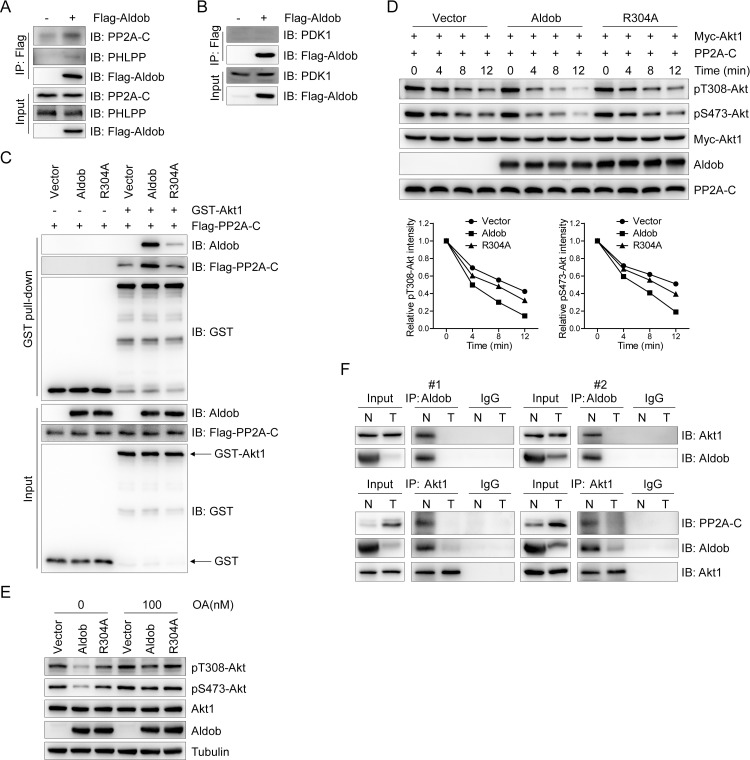
Aldob regulates Akt activity through protein phosphatase PP2A.(A and B) IB analysis of anti-Flag IP and WCL derived from Huh7 cells transfected with the indicated constructs. (C) GST pull-down assays were performed with WCL derived from Flag-PP2A-C-transfected Huh7 cells and recombinant proteins GST-Akt1 and WT-Aldob or Aldob-R304A mutant. GST was used as the negative control. (D) In vitro PP2A dephosphorylation assays were performed with phosphorylated Myc-Akt1 and active PP2A in the presence or absence of recombinant WT-Aldob or Aldob-R304A mutant (top). The relative signal intensities of pT308-Akt and pS473-Akt were quantified (bottom). (E) IB analysis of WCL derived from Huh7 cells transfected with the indicated constructs. Resulting cells were treated for 4 hours with OA at 100 nM. (F) IB analysis of endogenous anti-Aldob and anti-Akt1 IP and WCL derived from 2 pairs of human HCC samples. IgG was used as the negative control. The data underlying this figure can be found in S1 Data. Aldob, aldolase B; IB, immunoblot; IP, immunoprecipitation; GST, glutathione S-transferase; IgG, immunoglobulin G; OA, okadaic acid; PP2A, protein phosphatase 2A; WCL, whole cell lysate; WT, wild-type.